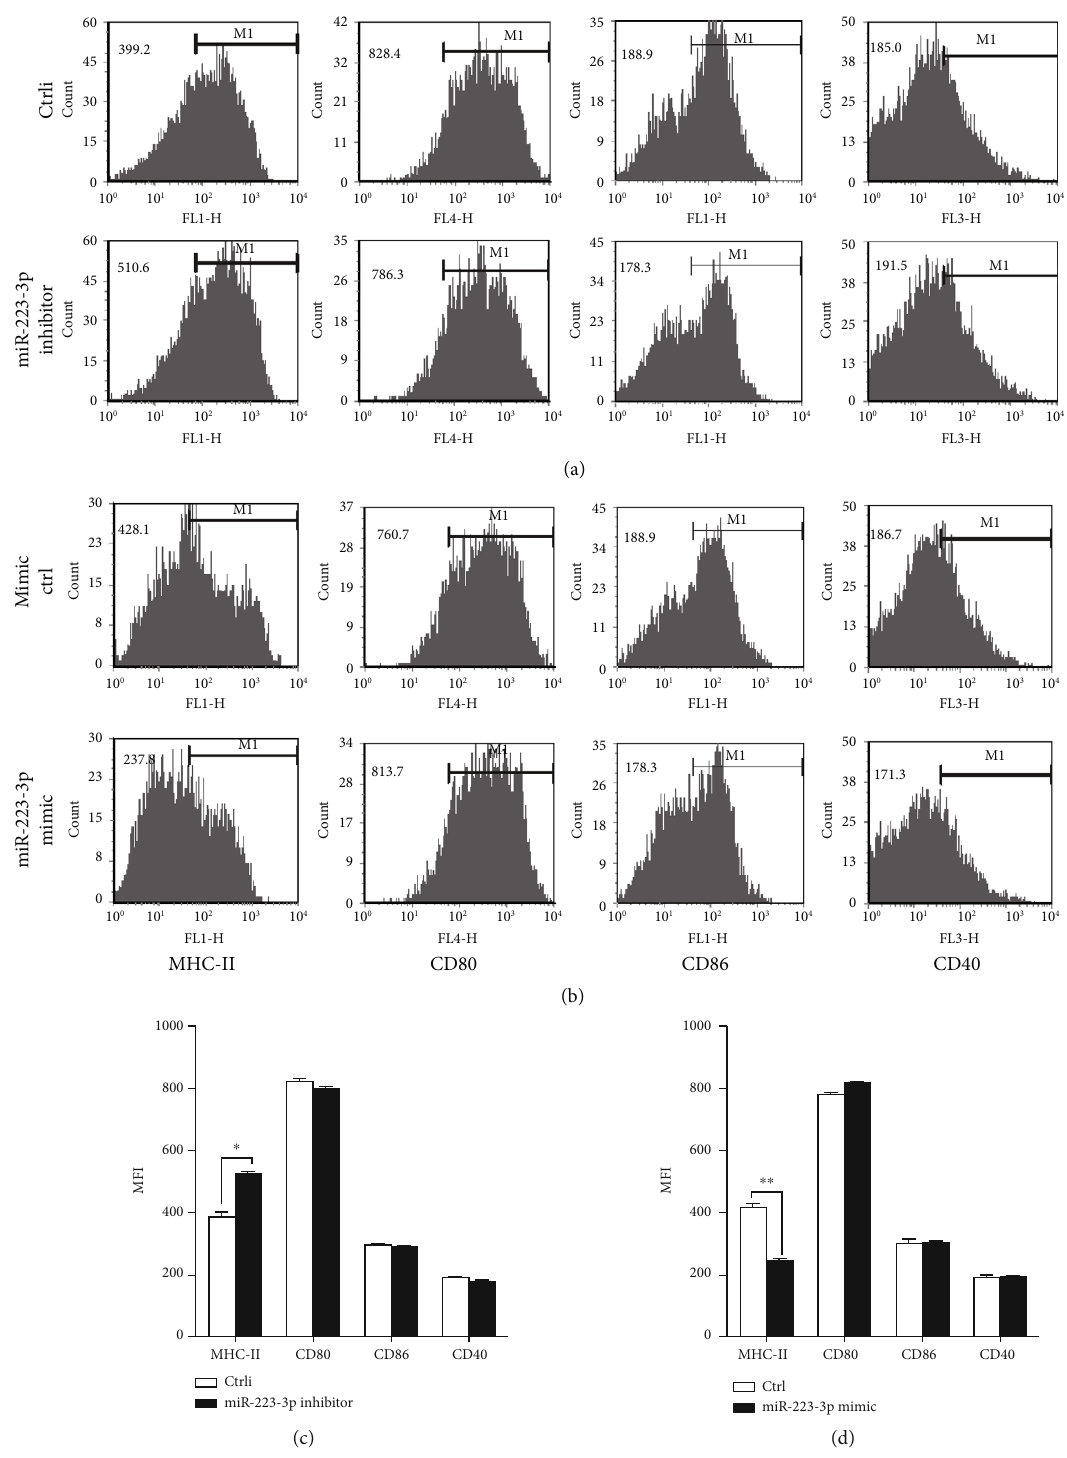
Figure 3: miR-223-3p suppressed surface molecule MHC-II expression on the OVA-induced BMDCs. Mouse immature DCs were transfected with the miR-223-3p inhibitor (a), inhibitor control, miR-223-3p mimic (b), or mimic control at a fi nal concentration of 50nM. After 24h, DCs were stimulated with 100 μ g/ml OVA for 24h and then stained with speci fi c Abs against MHC-II, CD80, CD86, and CD40 and then analyzed by fl ow cytometry. The bar chart indicated the MFI in the gate of CD11c+ cells in each group. Similar results were obtained in three independent experiments. Data were shown as mean ± SD . t -test, ∗ P < 0 : 05 , ∗∗ P < 0 : 01